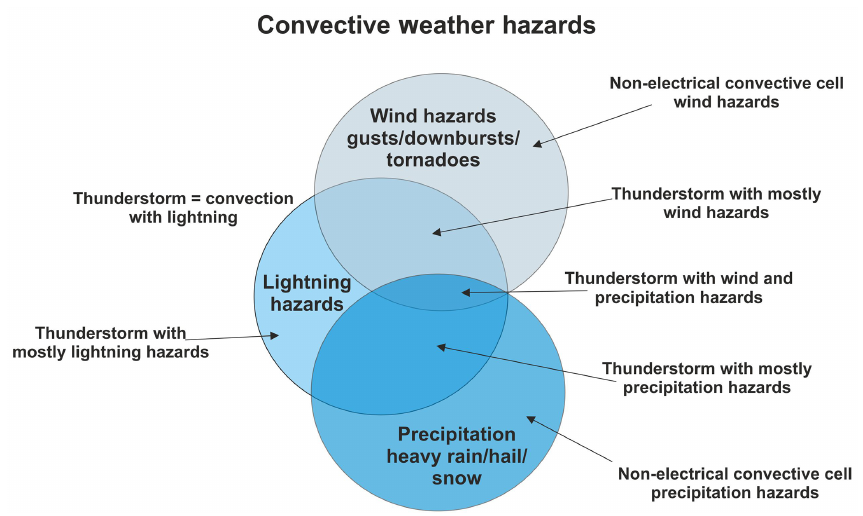
Figure 1. Venn diagram of the relationship between convective weather hazards and how thunderstorms are distinguished from ordinary convection by electrical